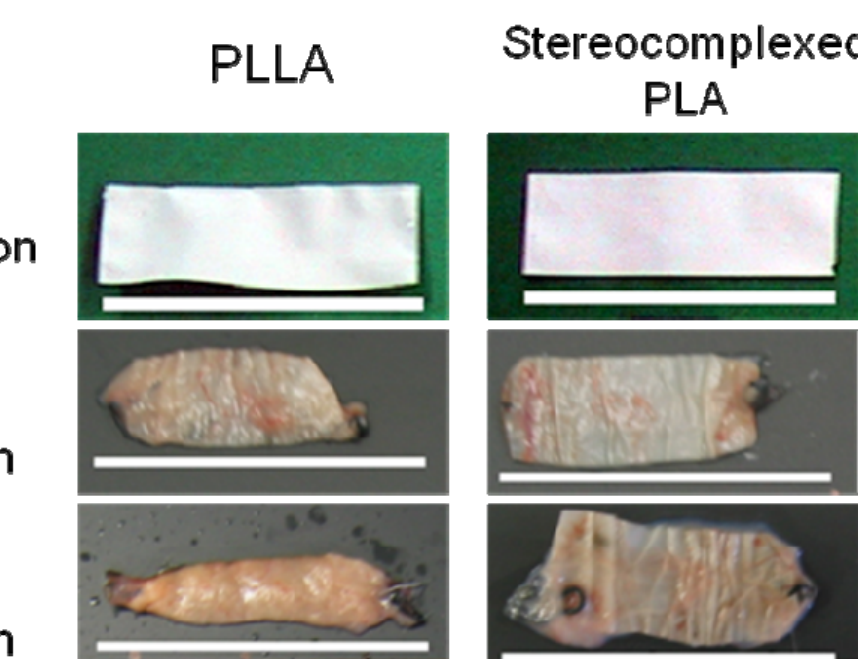
Figure 10. PLA nanofiber mats after subcutaneous implantation in rat for 4 to 12 weeks. Scale bars = 3cm